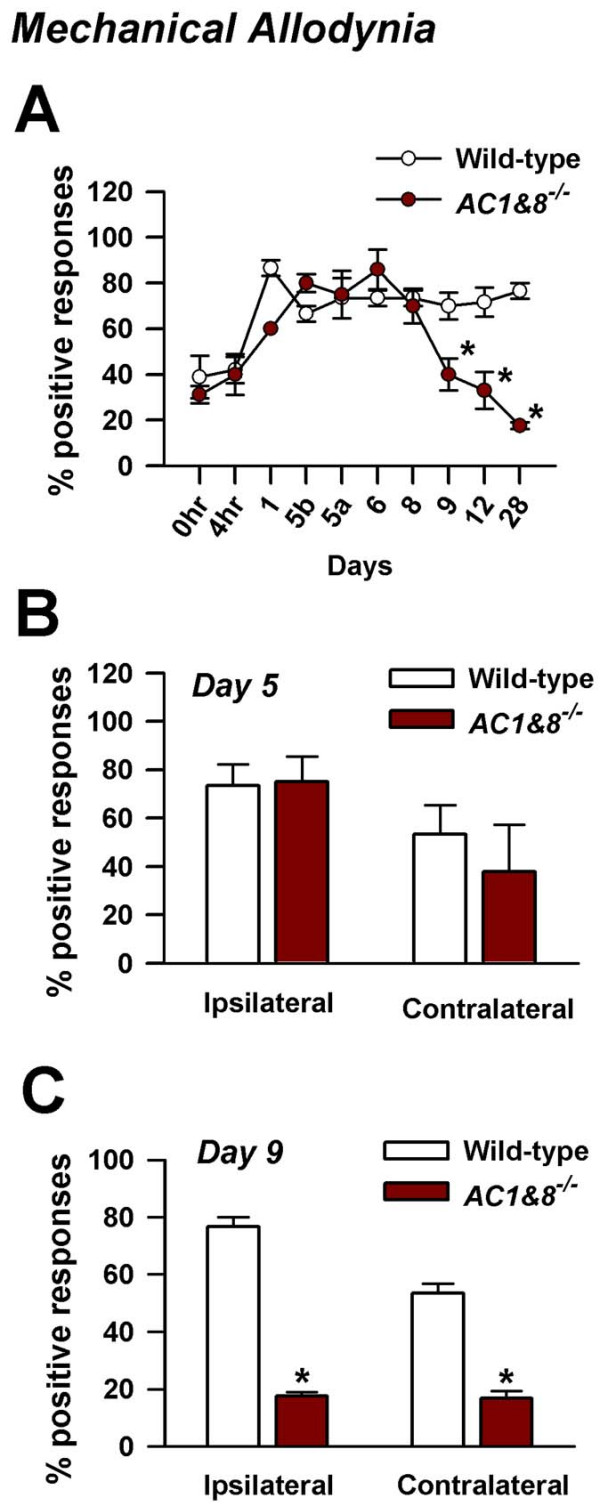
Mechanical allodynia in chronic inflammatory muscle pain. Intramuscular injections of carrageenan were given on day 1 and 5. The data is plotted as percentage of responses out of 10 mechanical stimuli over the dorsum of the foot at an interval of 5 min. Wild-type, n = 5 mice; AC1&8 DKO, n = 8 mice. A. The behavioral responses of animals to a non-noxious mechanical stimulus were recorded on the ipsilateral side. 5b denotes time point before second injection of carrageenan on day 5; 5a denotes time point after second injection of carrageenan on day 5. B. Mechanical allodynia on day 5 following the second intramuscular injection of carrageenan. There was no statistical difference between the wild-type and DKO mice on both ipsilateral and contralateral sides. C. Mechanical allodynia on day 9. Significant differences in mechanical allodynia were present between the wild-type and DKO mice on both ipsilateral and contralateral sides. p < 0.05. *Significant difference from wild-type mice.